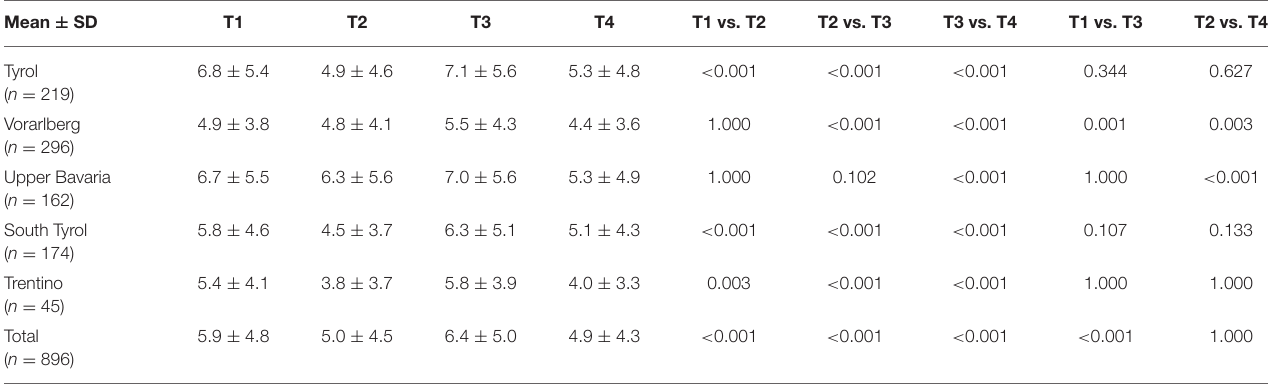
TABLE 3 | Amount of PA in the five Alpine regions at four time points. Mean ±